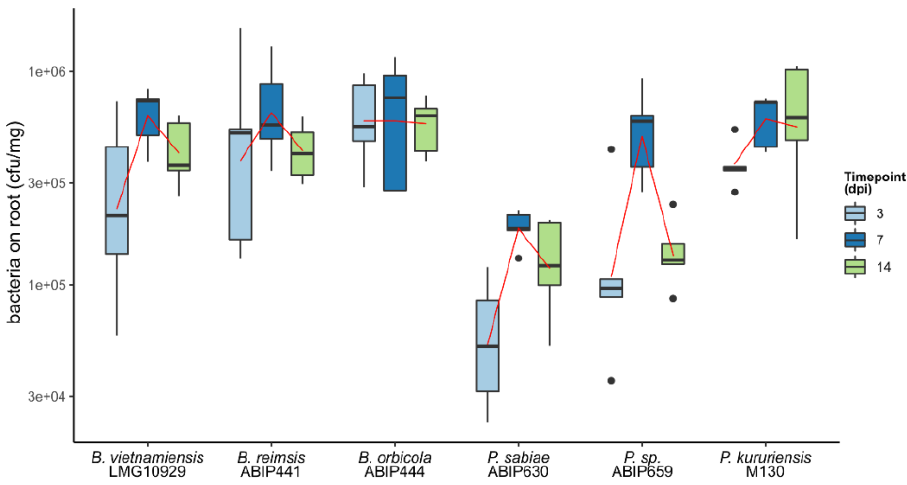
Figure 2 - Plant colonization efficiencies for six Burkholderia and Paraburkholderia strains. Nipponbare rice seedlings were inoculated at 5 days post-germination with 1.10 8 bacterial cells and grown in a hydroponic medium. Total roots were sampled at different time points (5 replicates each) and the attached bacterial population was enumerated. The trendlines (red) were inferred using the non-parametric regression LOESS method (Cleveland et al.,